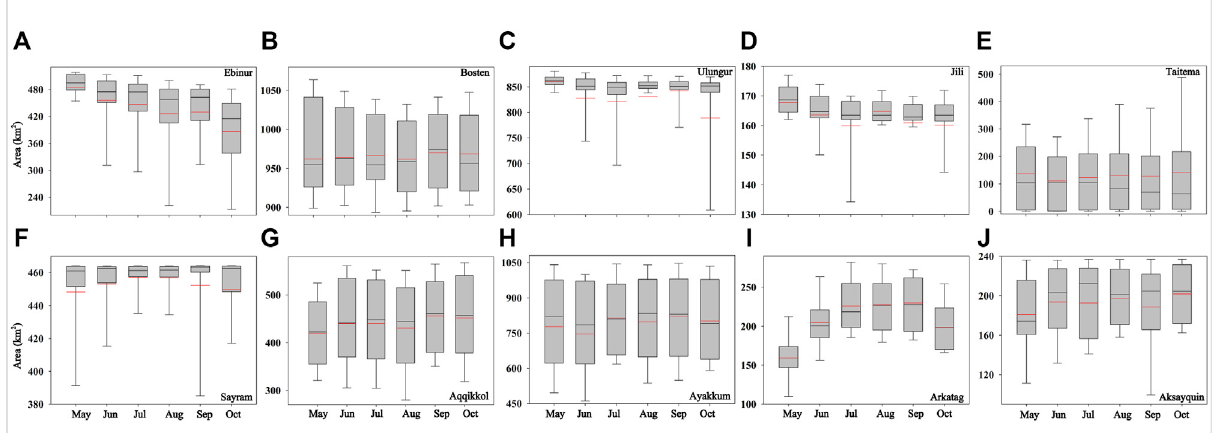
FIGURE 9 ArealchangesoftypicallakesinXinjiangindifferentmonthsfrom1986to2020 (A) LakeEbinure; (B) LakeBosten; (C) LakeUlungur; (D) LakeJili;